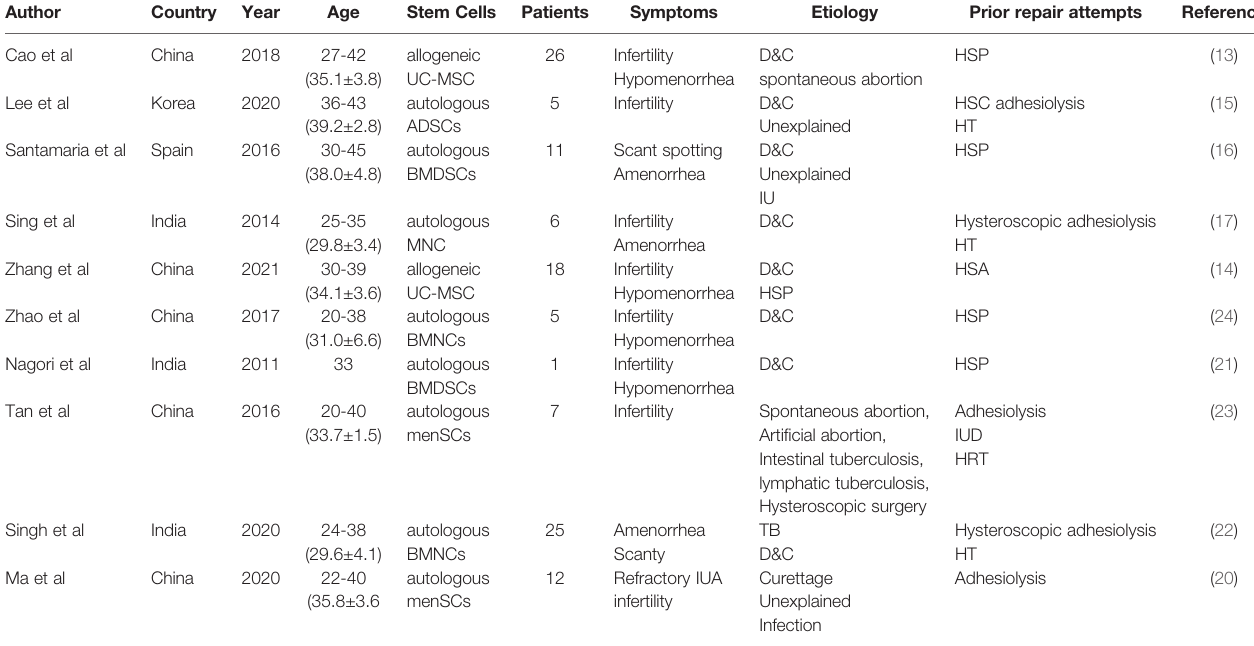
TABLE 1 | Characteristic of basic information.